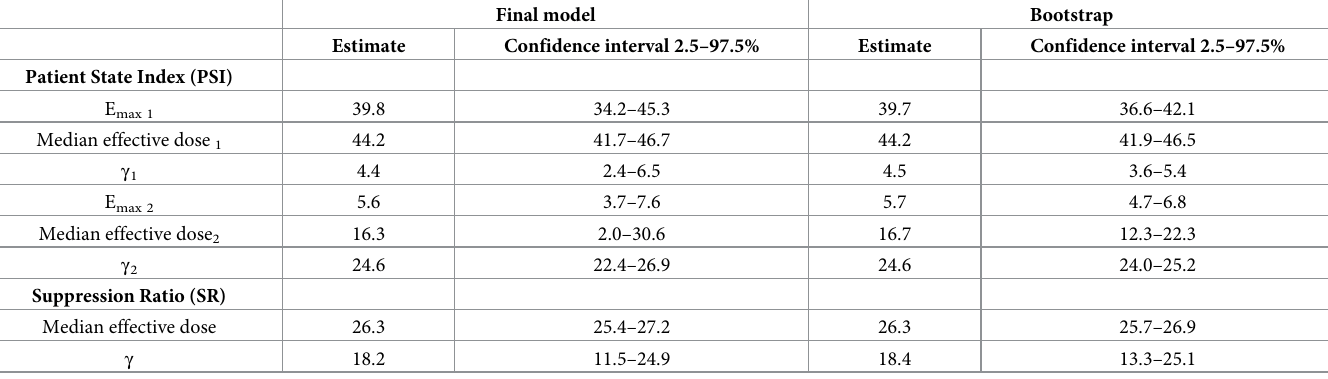
Table 2. Pharmacodynamic parameter estimates and confidence interval for the final model and Bootstrap (1000 simulations) for patient state index (PSI) and sup- pression ratio